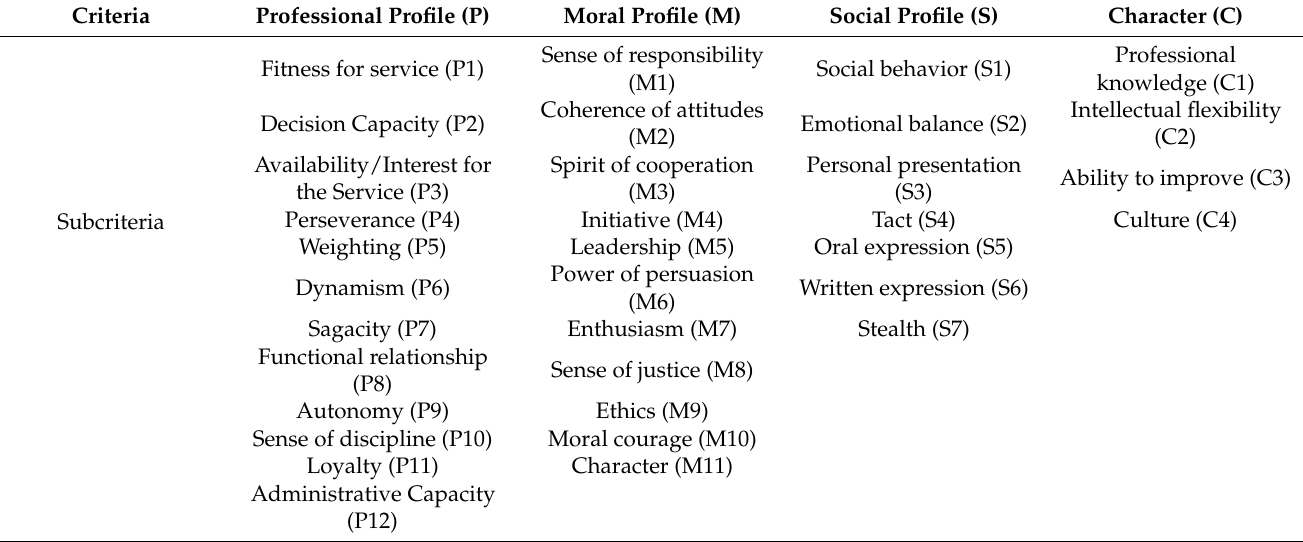
Table 3. Definition of the criteria and subcriteria of the problem.